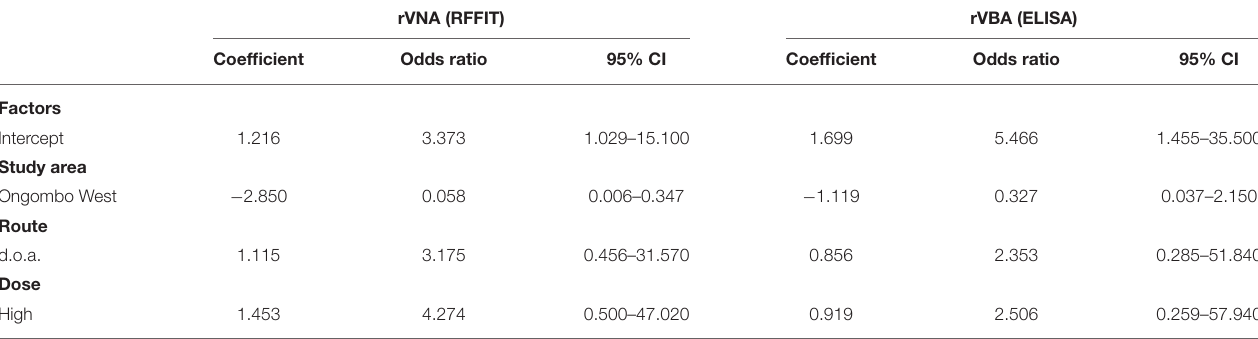
TABLE 2 | Parameter estimates from the multiple logistic regression model (linear without interactions) indicating factors associated with seroconversion (ELISA and RFFIT) in local dogs in